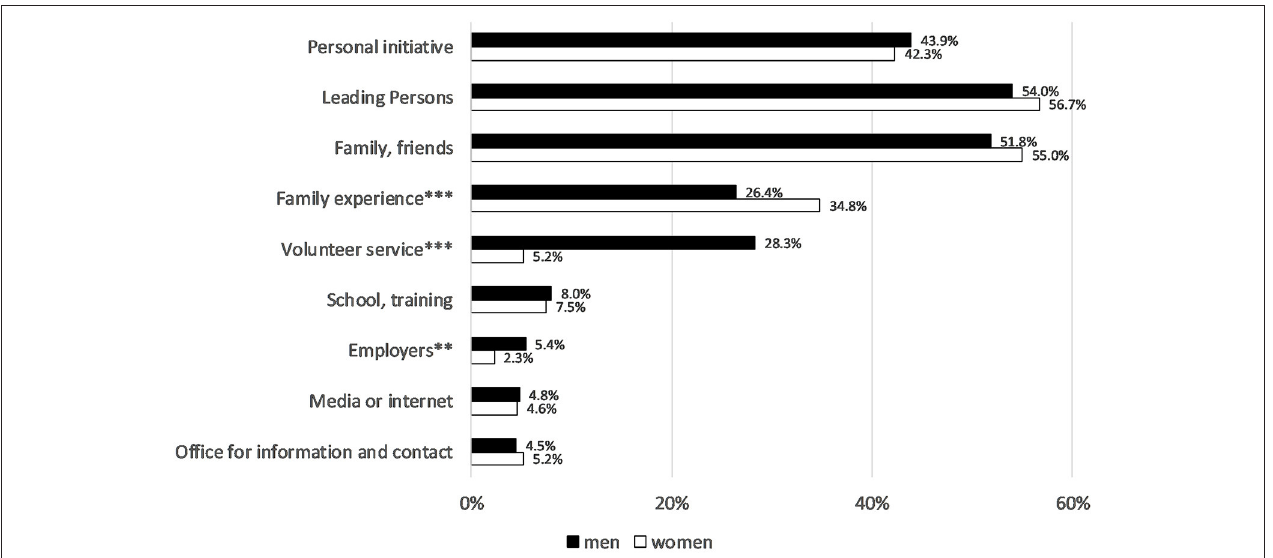
FIGURE 2 | Impulses for volunteer activity in 2019. Approval ratings in %, gender differences using Chi 2 test: * p < 0.05, ** p < 0.01, *** p < 0.001. German Survey on Volunteering (FWS).